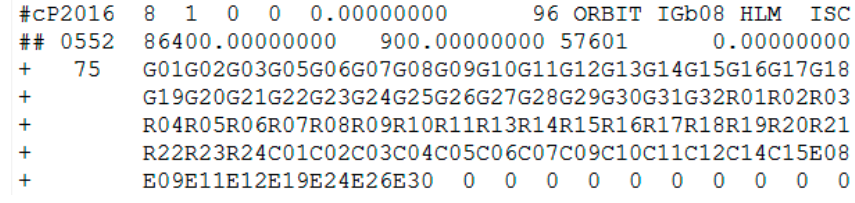
Figure 11. The header of precise orbits results of iGMAS on 1 August 2016.